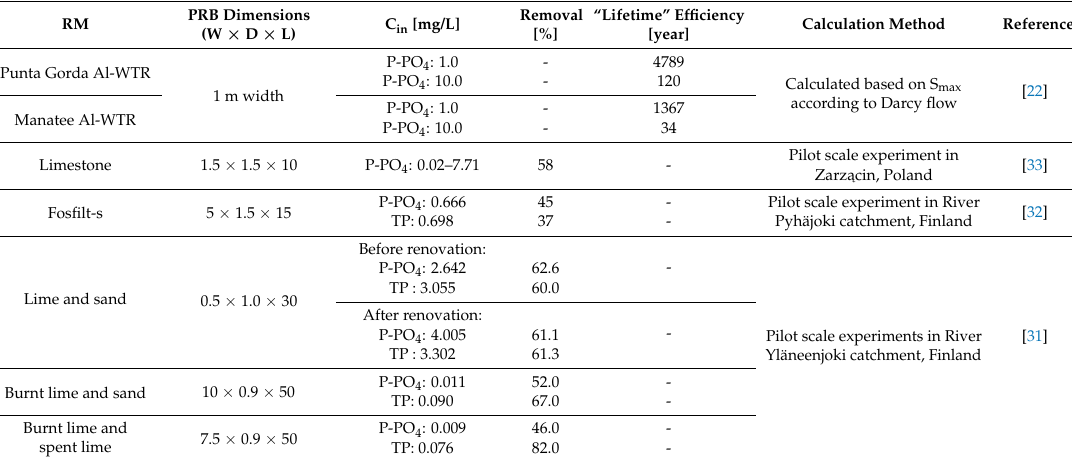
Table 4. Comparison of PRBs based on literature